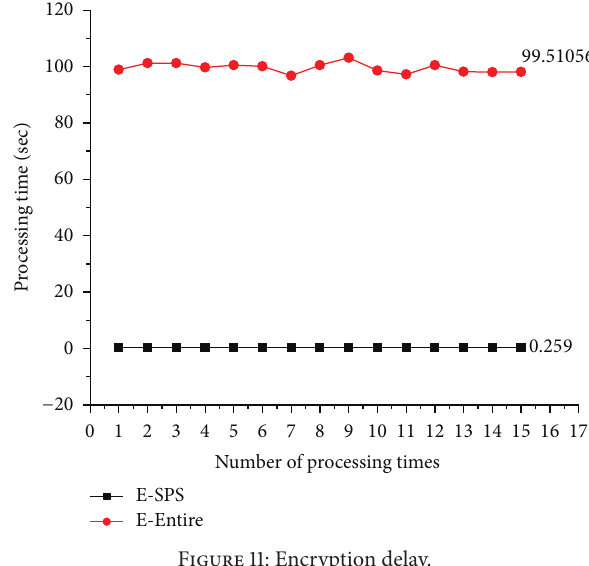
Figure 11: Encryption